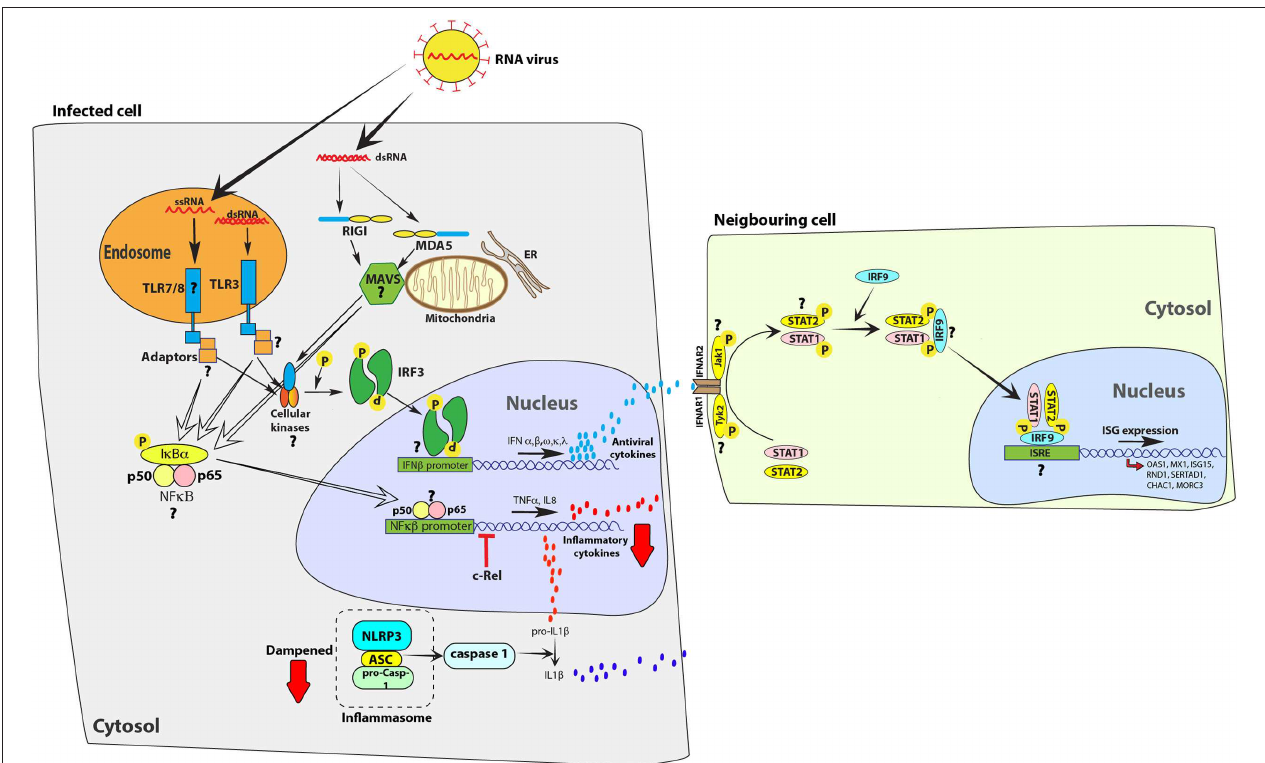
FIGURE 1 | Bat cells mount an antiviral response to RNA viruses, but limit the expression of inflammatory cytokines. Infection with RNA viruses, such as Sendai virus, or transfecting cells with surrogate double-stranded RNA [poly(I:C)] or single-stranded RNA is detected by Toll-like receptors (TLRs) 3, 7 and 8 or cytosolic receptors retinoic acid-inducible gene-I (RIG-I) and melanoma differentiation-associated protein 5 (MDA5). Activation of these receptors activate downstream adaptor proteins, such as mitochondrial antiviral signaling protein (MAVS). Adaptor proteins activate cellular kinases, such as TANK-binding kinase 1 protein (TBK1), which in-turn activate interferon regulatory factor 3 (IRF3) or IRF7 and nuclear factor kappa-light-chain-enhancer of activated B cells (NF κ B) to stimulate the expression of interferons (IFNs), such as IFNs α , β , ω , κ , and λ , and pro-inflammatory cytokines, such as IL8, TNF α , and IL1 β , respectively. IFNs bind to interferon α / β receptors (IFNAR; IFNAR1 and IFNAR2) on infected and neighboring cells to activate the JAK-STAT signaling pathway via kinases such as Janus kinase 1 (Jak1) and tyrosine kinase 2 (Tyk2) that phosphorylate signal transducer and activator of transcription (STAT) proteins. Phosphorylated STAT proteins (STAT1 and STAT2) merge with IRF9 and induce the expression of interferon stimulated genes (ISGs), such as OAS1 and Mx1. However, unlike in human cells, the parallel activation of pro-inflammatory cytokines is dampened in bat cells. c-Rel, a protein from the NF κ B family of proteins binds to the TNF α promoter to inhibit activation of this pro-inflammatory cytokine in E. fuscus cells (49). The bat NLRP3 inflammasome activation is dampened, reducing the ability of bat cells to produce IL1 β , a key inflammatory cytokine (17). In the figure, red arrows indicate a dampened response in the pathway, relative to human cells. Question marks ( ? ) highlight pathways and molecular homologs that have not been characterized or identified in bats. The data have been compiled from studies in different species and one finding may not represent a universal bat response. ER, endoplasmic